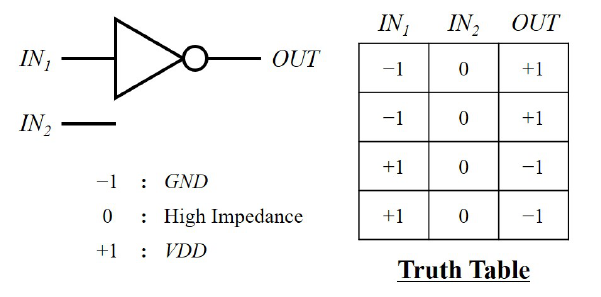
Figure 6. Truth table for an inverter circuit. Because it is an one-input gate, IN 2 is kept at high impedance by assigning 0, where +1 is VDD , and − 1 is GND